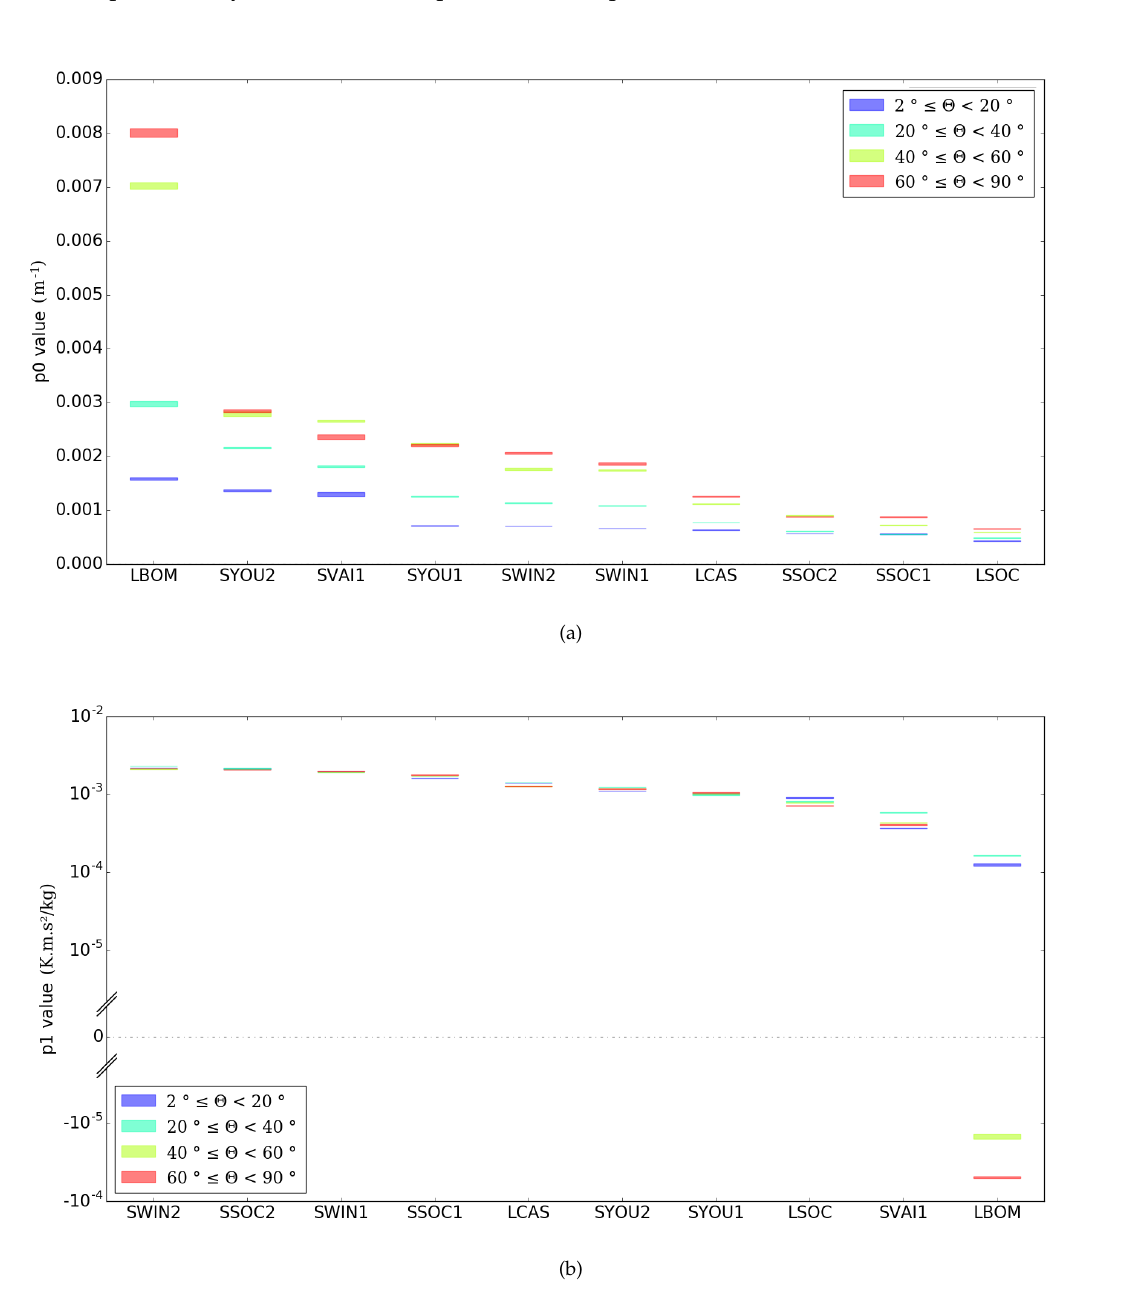
Figure 12. Values of the regression coefficients ( a ) p 0 and ( b ) p 1 for different solar angle azimuth